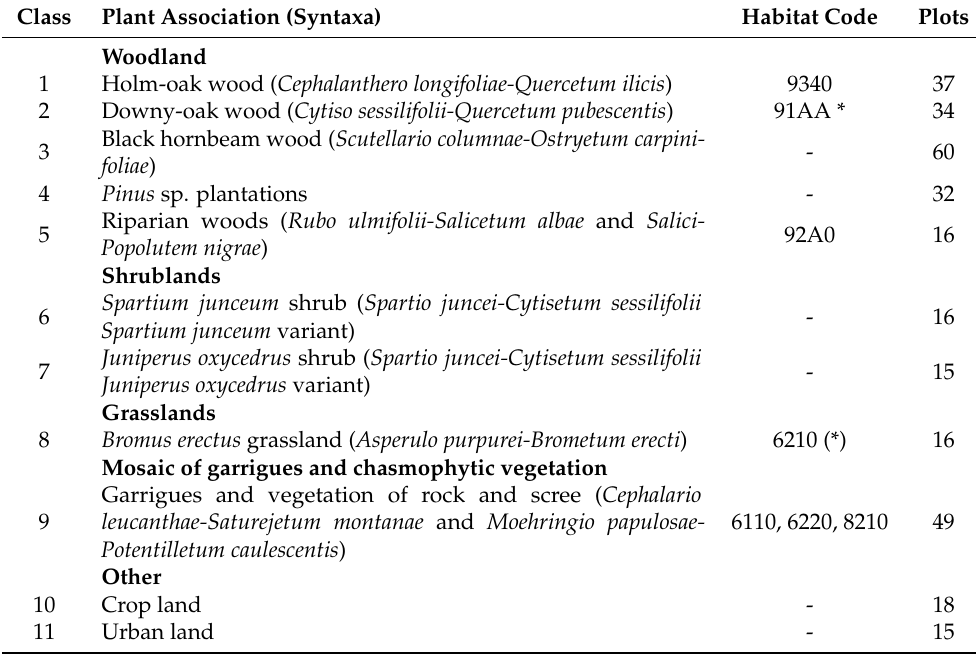
Table 1. Reference data. Target classes for the supervised map are listed. For plant associations, we report the syntaxa name and the corresponding habitat code (Annex 1 of the European Union Habitats Directive). The * denotes a priority habitat. In the case of 6210 if is an important orchid sites